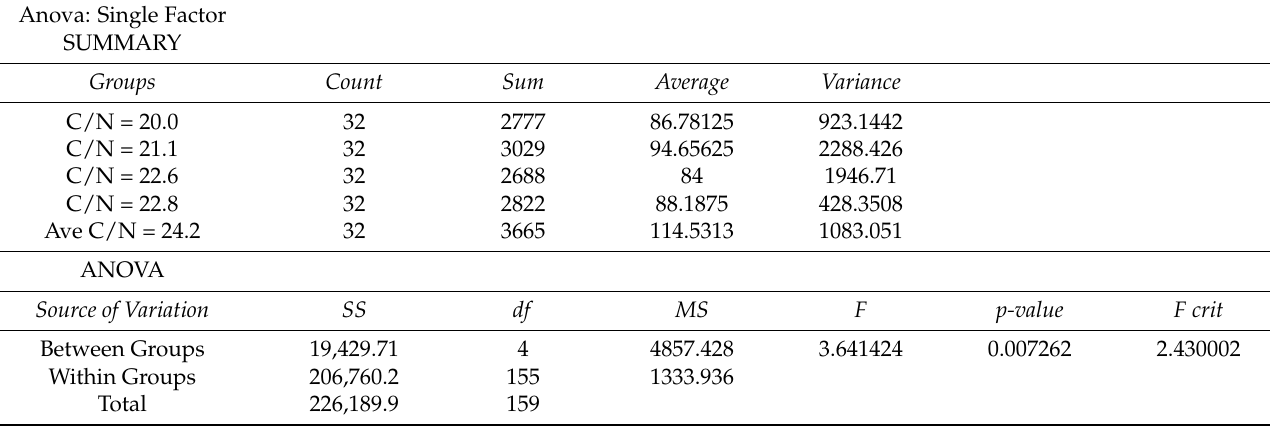
Table A2. One-way (ANOVA) test for daily biogas yield from the first five